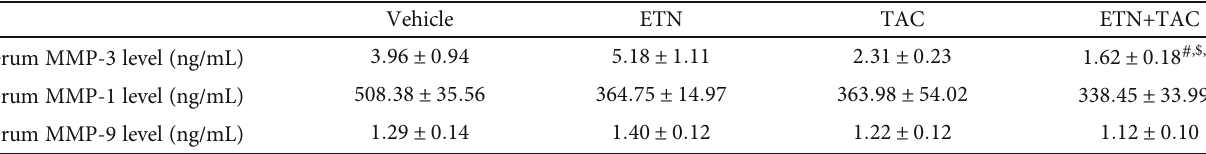
Etanercept (ETN; 4mg/kg) was administered subcutaneously twice a week for 4 weeks. Tacrolimus (TAC; 3mg/kg) was administered orally once daily for 4 weeks. The serum MMP-1, MMP-3, and MMP-9 levels were measured by ELISA. Data are representative of two independent experiments and presented as mean ± SEM of fi ve animals per group. # p < 0 : 05 compared with the vehicle group (Dunnett ’ s multiple comparison test). $ p < 0 : 05 and ∗ p < 0 : 05 compared with the tacrolimus-treated group (Student ’ s t -test) and the etanercept-treated group (Aspin-Welch ’ s t -test),